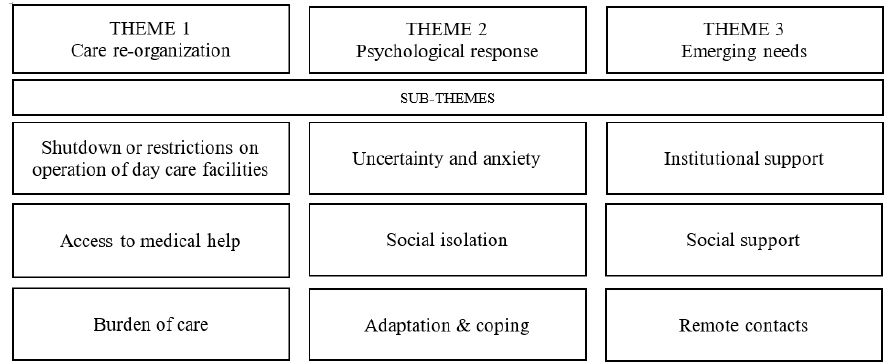
Figure 1. Themes and sub-themes.